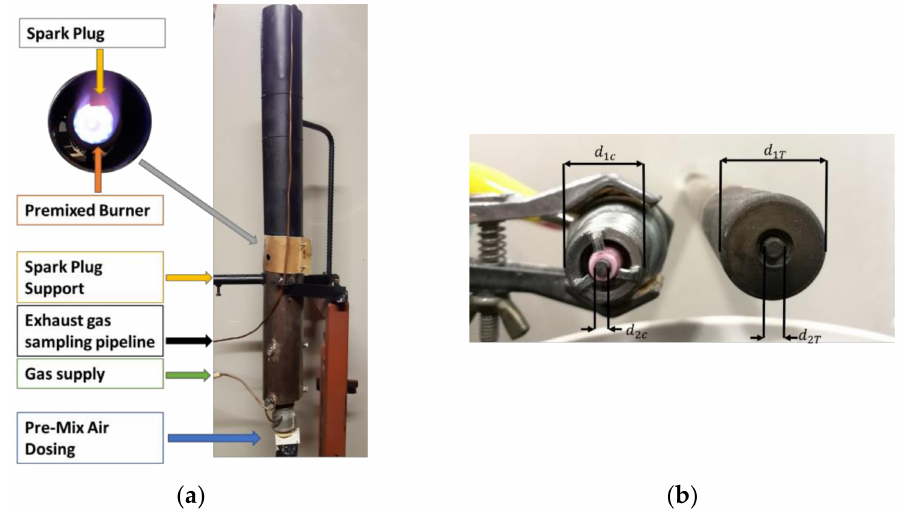
Figure 5. ( a ) The burner test bench used for the experiments. ( b ) The two spark plugs used for the experiments.